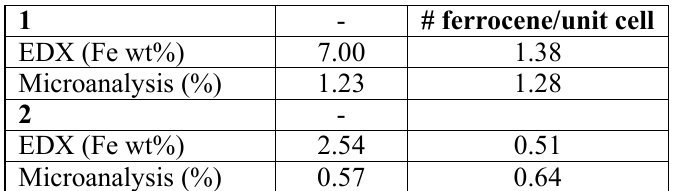
(bdc) (dabco)] ( 1 ) 2 2